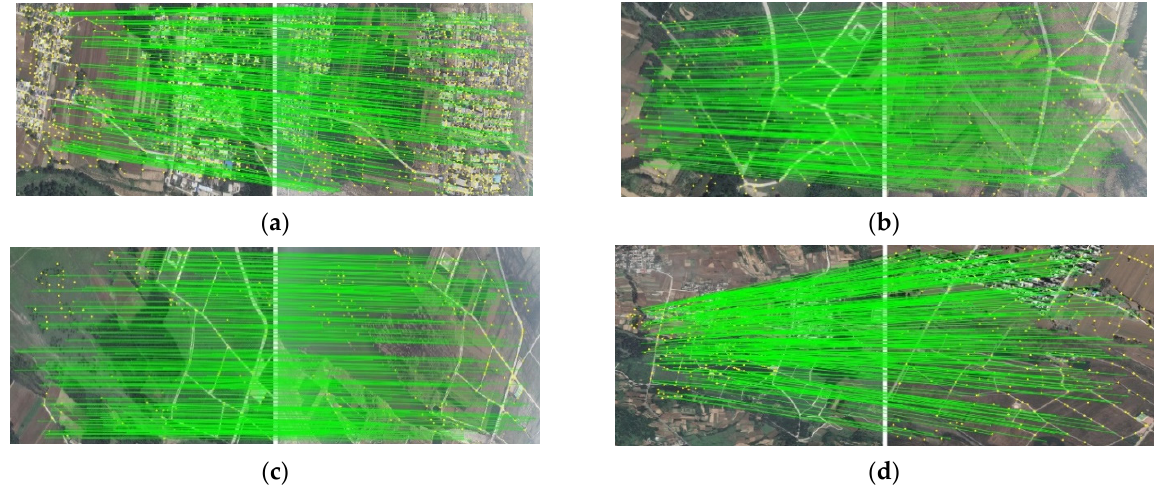
Figure 10. Matching results of the SD-ME algorithm: ( a ) image pair a, ( b ) image pair b, ( c ) image pair c, and ( d ) image pair d. Note: the yellow dots are the initial matches found by the SuperGlue algorithm, and green lines are the augmented results.